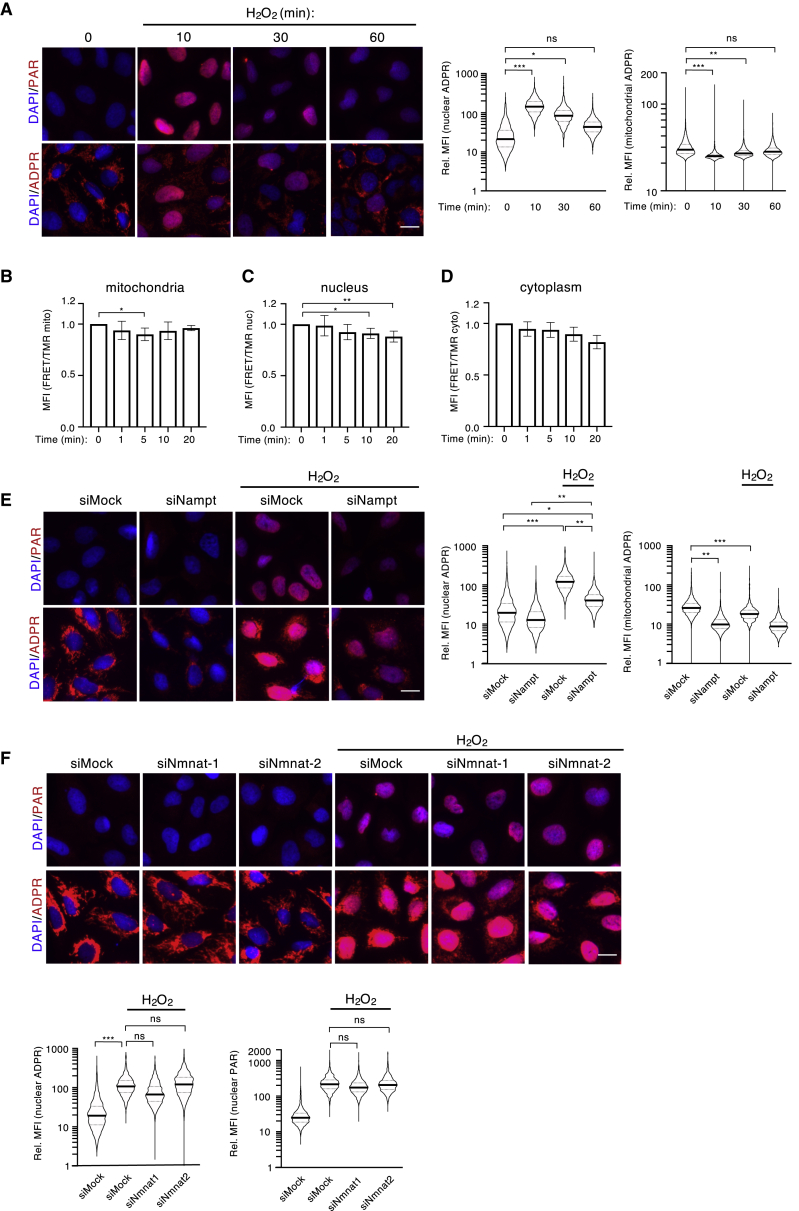
Mitochondria-Derived NAD+ Is Crucial for the Formation of Nuclear PAR(A) U2OS cells were treated with H2O2 for the indicated amount of time. Nuclear and mitochondrial ADP-ribosylation were assessed by IF using an anti-PAR antibody (upper pictures) and an anti-ADPr antibody (lower pictures, both red). Representative pictures for each condition are shown on the left; the quantification of nuclear (left) and mitochondrial (right) IF signals detected with the anti-ADPr antibody is depicted on the right.(B–D) Stable U2OS Flp-In T-Rex cells expressing inducible NAD+ sensors targeted to the mitochondria (B), the nucleus (C), or the cytoplasm (D) were subjected to H2O2 treatment, and NAD+ levels in each compartment were assessed at various time points via flow cytometry. Increased FRET ratios correspond to increased NAD+ levels. FRET ratios of three independent experiments including square deviation are shown.(E) U2OS cells were transfected with siRNA targeting NAMPT and treated with H2O2, and nuclear and mitochondrial ADP-ribosylation was analyzed by IF using an anti-PAR antibody (upper pictures) and an anti-ADPr antibody (lower pictures). Representative pictures for each condition are shown on the left; the quantification of nuclear (left) and mitochondrial (right) IF signals detected with the anti-ADPr antibody is depicted on the right.(F) U2OS cells were transfected with siRNA targeting NMNAT1 or 2 and treated with H2O2, and nuclear ADP-ribosylation was analyzed via IF using an anti-PAR antibody (upper pictures) and an anti-ADPr antibody (lower pictures). Quantification of the signals detected by the anti-ADPr antibody (left) and the anti-PAR antibody (right) are shown in the lower panel. The quantifications of all signals (mitochondrial and nuclear) were normalized as described in Figure 1, and the y axes of all plots are depicted as log10 scale. Scale bars indicate 20 μm. For statistical analysis, a Student’s t test was performed (n = 3–5; ∗p < 0.05; ∗∗p < 0.005; ∗∗∗p < 0.0005).